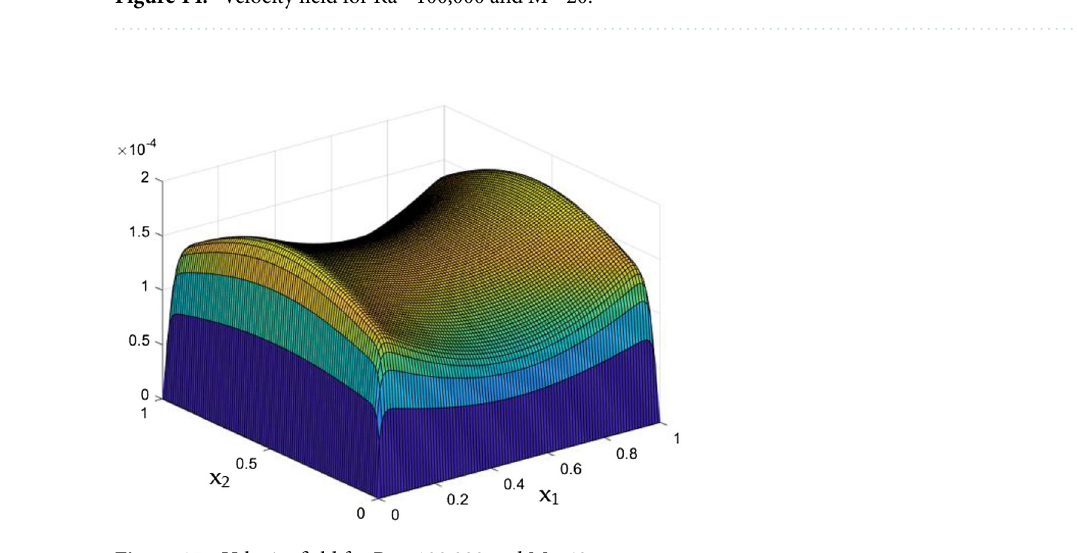
Figure 14. Velocity field for Ra = 100,000 and M = 20.